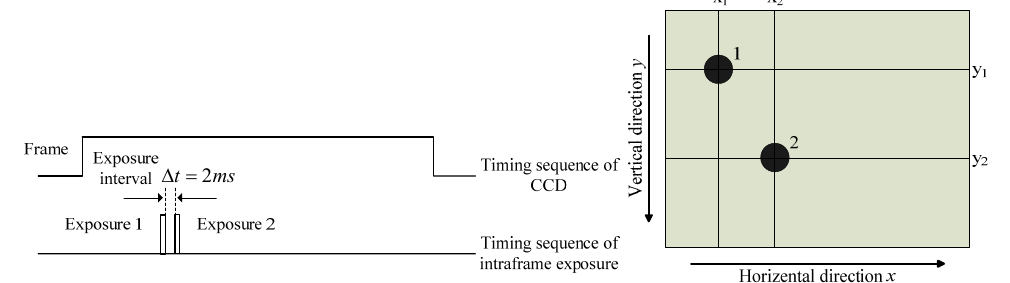
Figure 3. The timing sequence of exposure and images recorded by VPS. 2